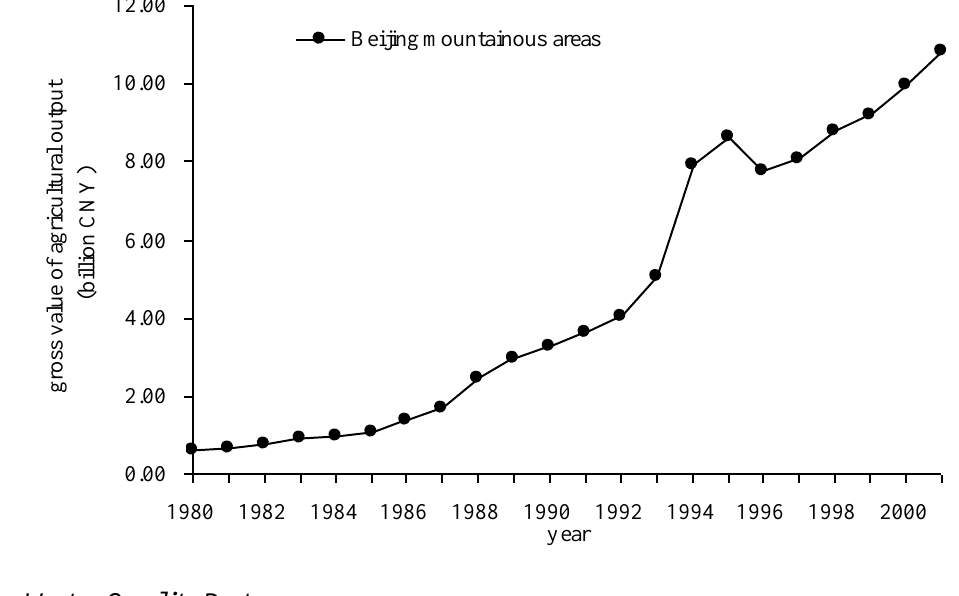
Figure 2. Gross agricultural output for the Beijing mountainous